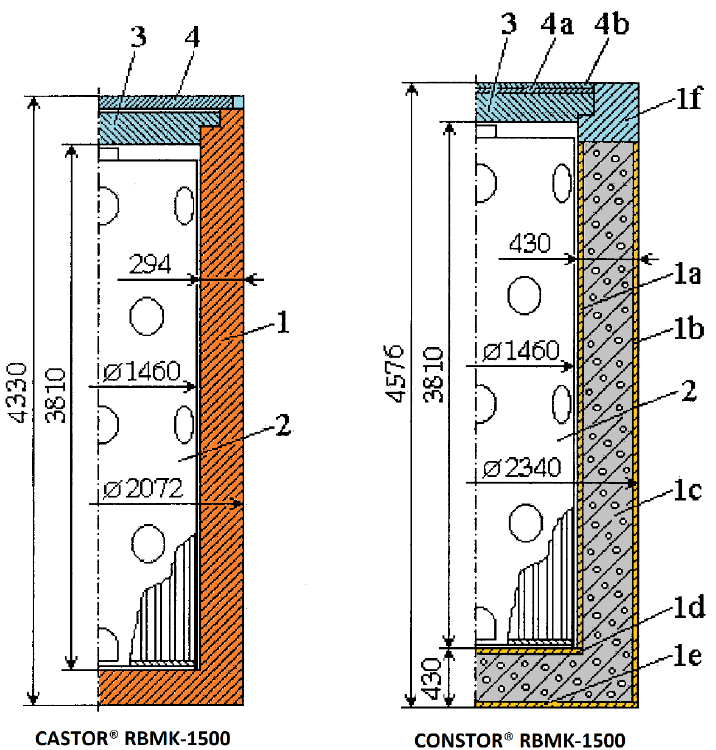
Figure 1. Cross-sections of the dry storage containers (1 — container body (1a,b,d,e,f — metal parts;